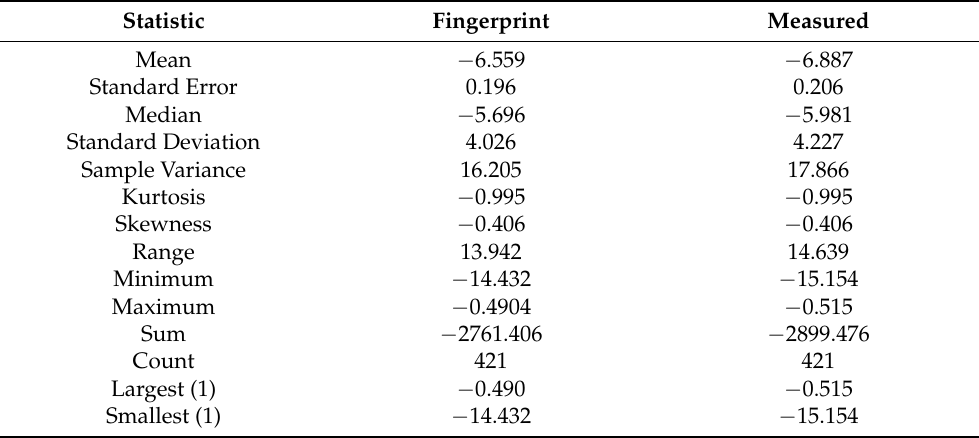
Table 5. Sub-region 1: Descriptive statistics comparison between fingerprint and measured FRA